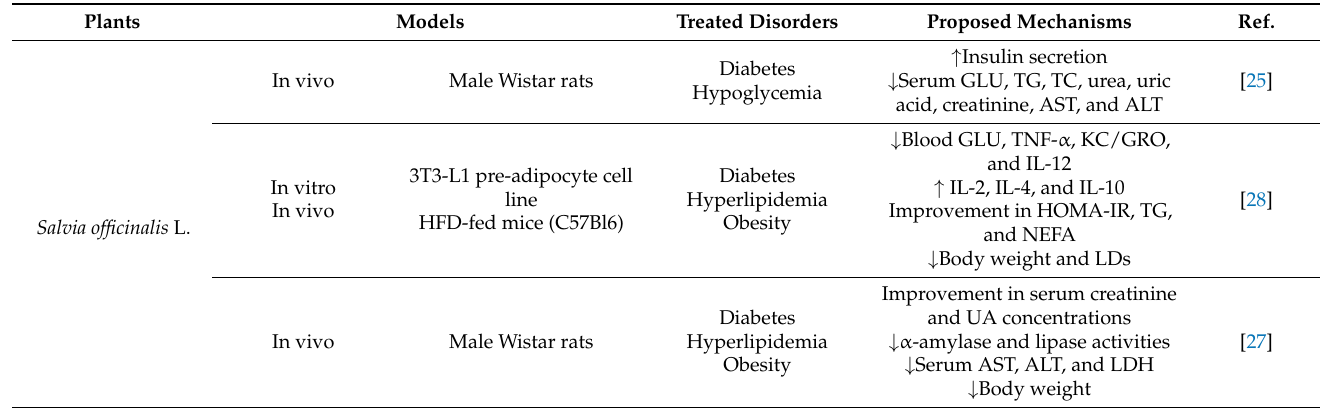
Table 2. Main in vitro and in vivo (animal models) studies with the different species of the Lami- aceae